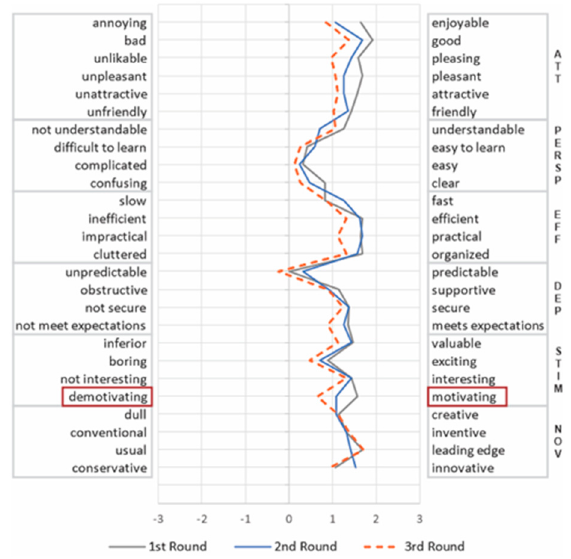
Figure 5. Variation of UEQ evaluated items over time.